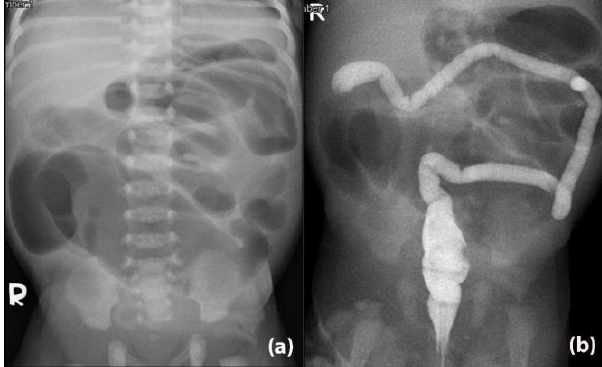
Figure 1: (a) Plain abdominal radiograph showed dilated loops of bowel, (b) microcolon up to hepatic flexure seen on contrast enema.